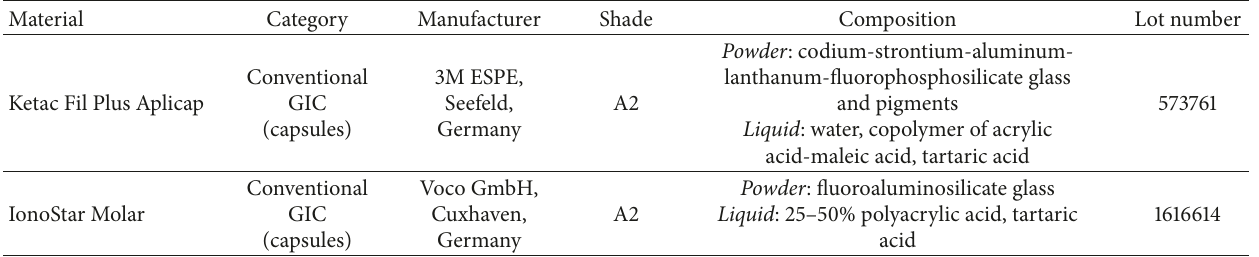
Table 1: The technical characteristics of the tested glass ionomer